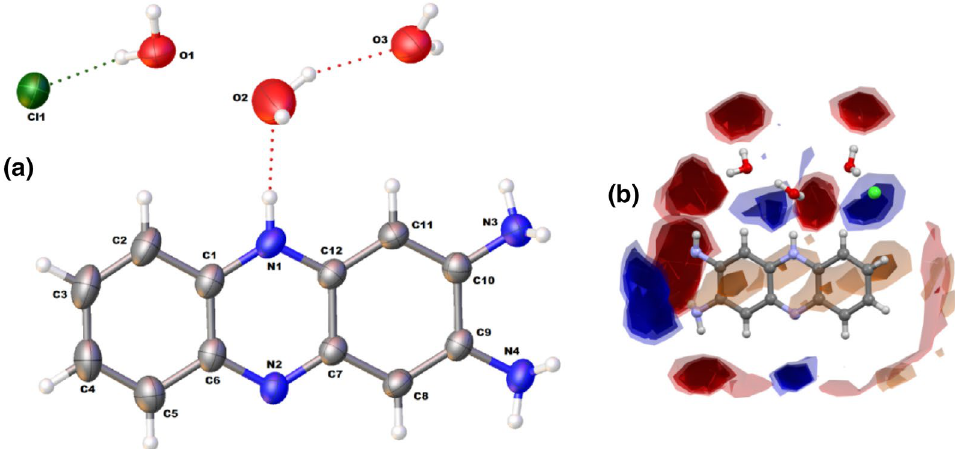
Figure 4. ( a ) An ORTEP diagram of the hydrated DAPH + Cl − with 30% probability; ( b ) Interaction map of DAPH + Cl − showing the suitability of interactions adopting the intensified red and blue regions.